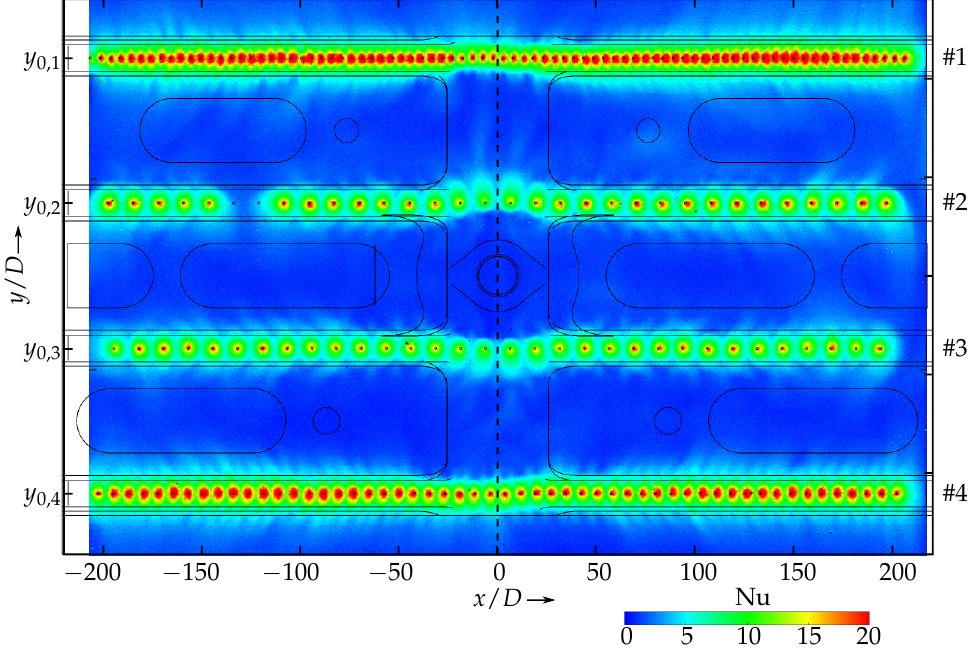
Figure 7. Local Nusselt numbers for Re =